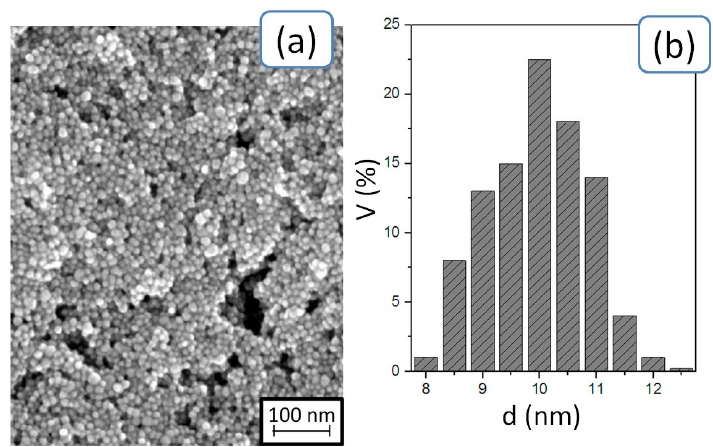
Figure 1. SEM image of Ag nanoparticles ( a ) and a histogram of the particle size distribution ( b ). The electrode structures were deposited on 380 µm thick YX lithium niobate (LiNbO 3 ) wafer (Crystal Technology Inc., West Chester, PA, USA). Si wafer 525 µm thick was used as reference material for investigation of the influence of incineration temperature on the morphology and the resistivity of the inkjet printed electrodes.